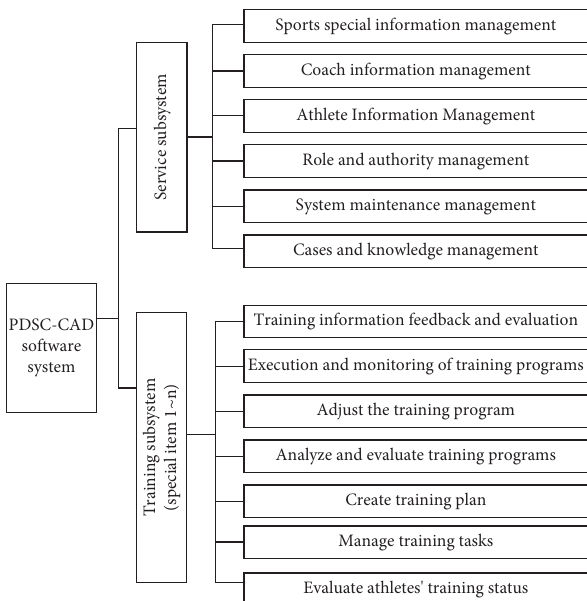
Figure 4: CAD auxiliary intelligent technology function